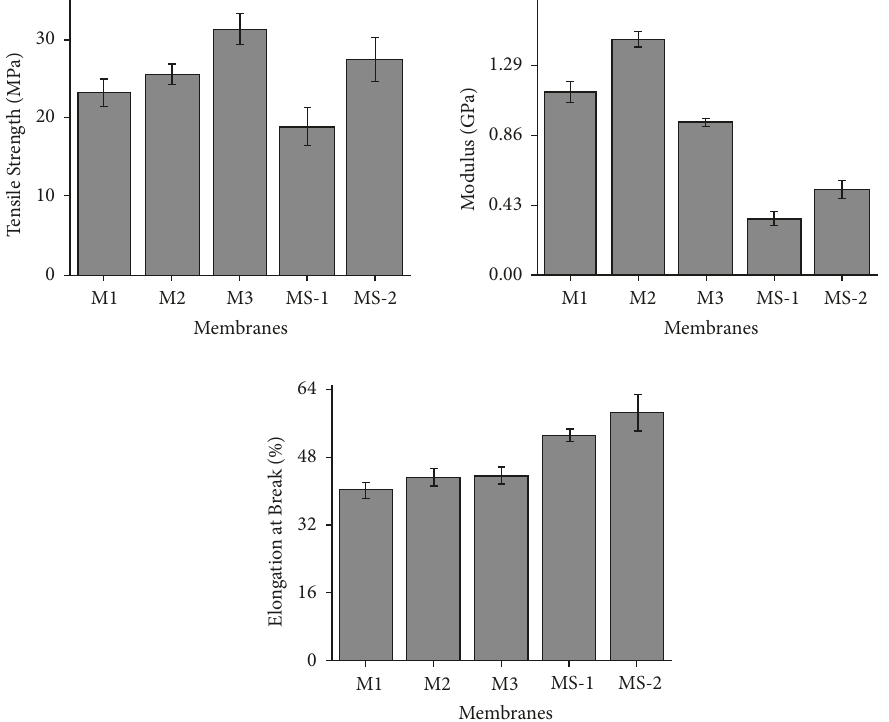
Figure 6: Tensile strength, elongation at break, and modulus of prepared membranes.